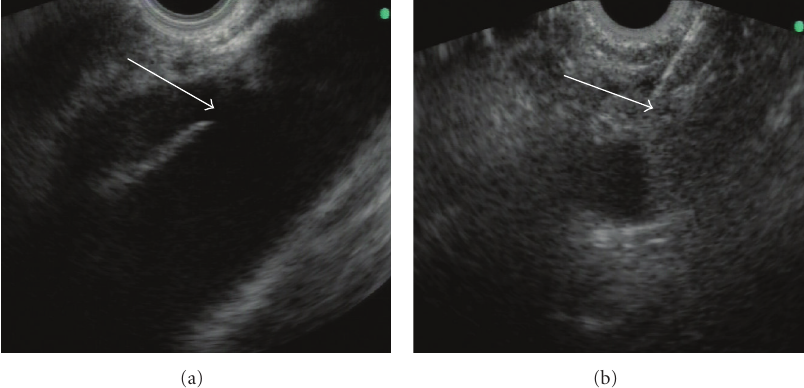
Figure 2: Endoscopic ultrasound-guided celiac plexus neurolysis: (a) typical location of the plexus with the celiac trunk (arrow) at the aorta, (b) puncture of the celiac plexus with administration of alcohol under endoscopic ultrasound